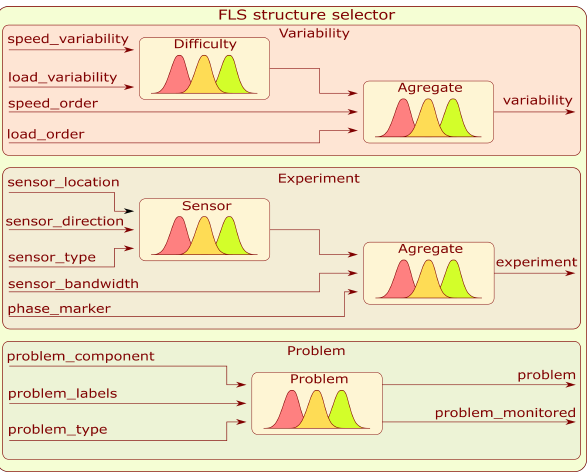
Figure 5. Block diagram of structure selector